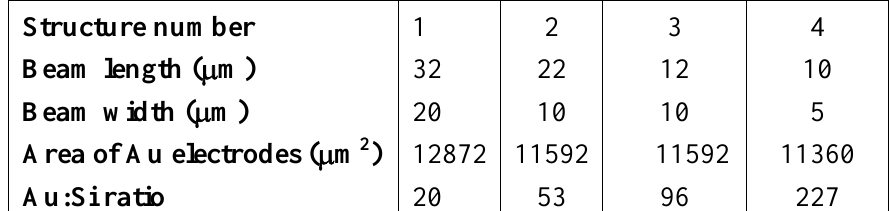
Table 1. The sizes of the beams and the Au